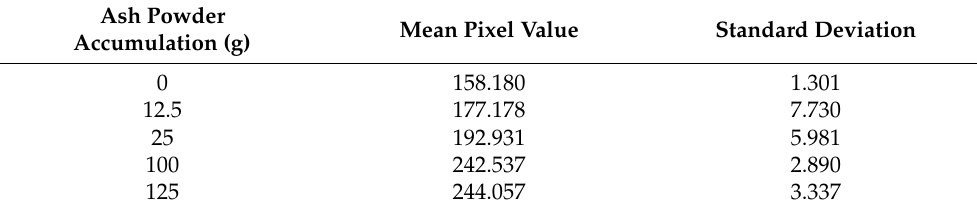
Figure 9. The graph of pixel values according to ash powder accumulation condition. Table 8. Pixel values according to each accumulation condition (ash powder).